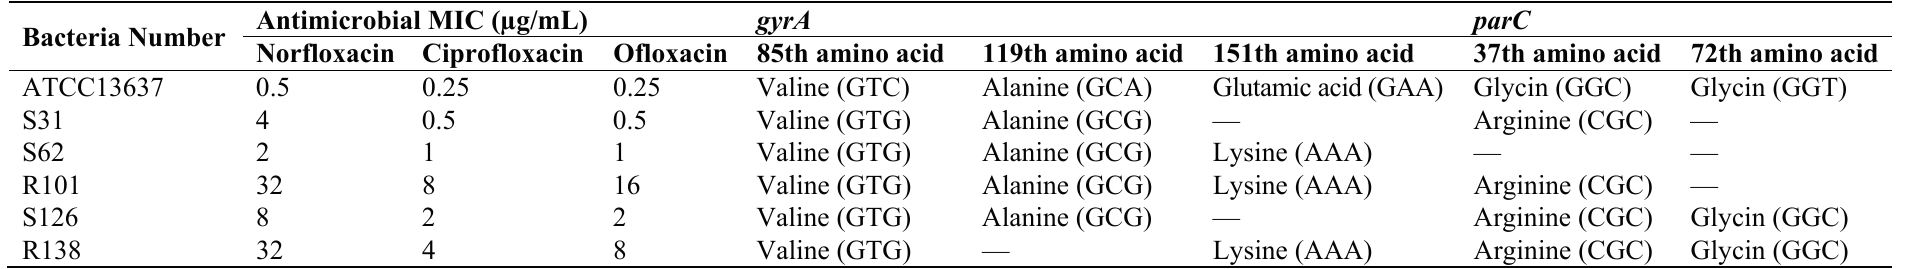
Table 8. Amino acid mutation in gyrA and parC genes of 5 Stenotrophomonas maltophilia isolates and MIC of three fluoroquinolone agents. Bacteria Number